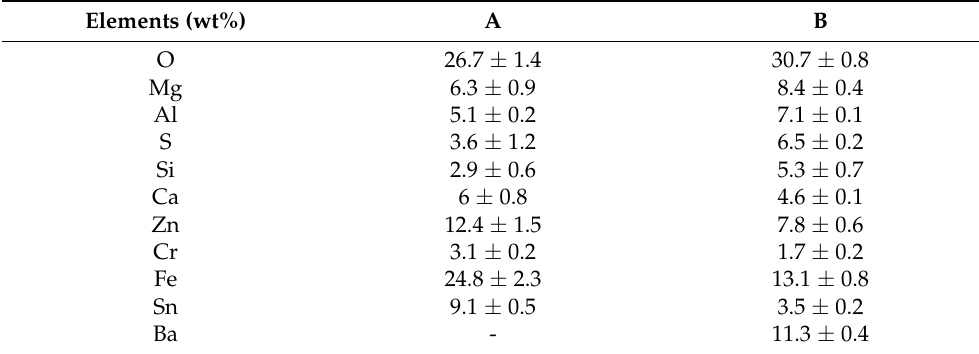
Table 2. EDXS analysis of the friction materials used for PoD tests. Note: carbon concentration was not